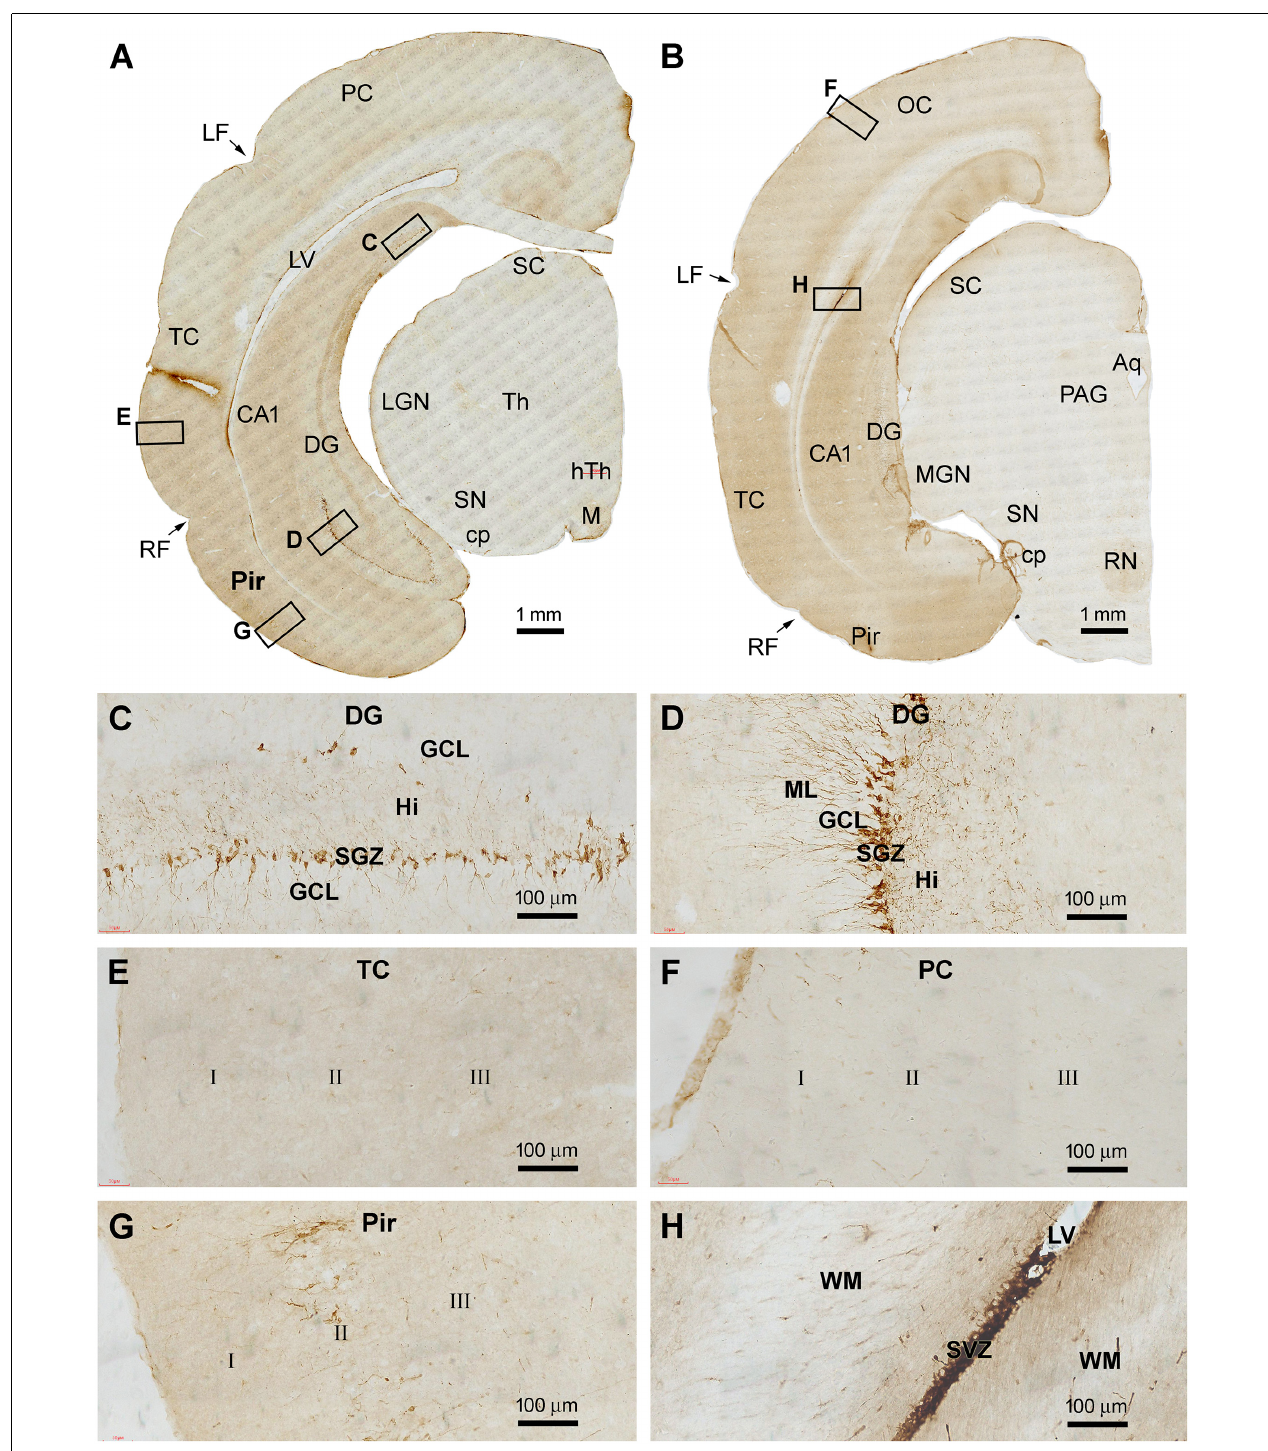
FIGURE 3 | DCX+ cellular profiles in the caudal part of the forebrain in a 2 months-old Chinese tree shrew. Panels (A,B) are low magnification views of immunolabeled hemispherical sections at two caudal levels of the hippocampus, with framed areas enlarged as panels (C–H) . DCX+ neurons in the dentate gyrus are separately located at the most dorsal and ventral parts of the hippocampal formation (C,D) . Again, DCX+ neuronal somata and processes are not found in the temporal and parietal cortical areas (E,F) , but are present in the piriform cortex over layer II (G) . DCX+ cells are also found at the subventricular zone in the temporal and occipital lobes (H) . Abbreviations are as defined in Figures 1 , 2 , and the following: cp, cerebral peduncle; hTh, hypothalamus; M, mammillary body; OC, occipital neocortex; MGN, Medial geniculate nucleus; RN, red nucleus; Aq, aqueduct; PAG, periaqueductal gray. Scale bars are as indicated.